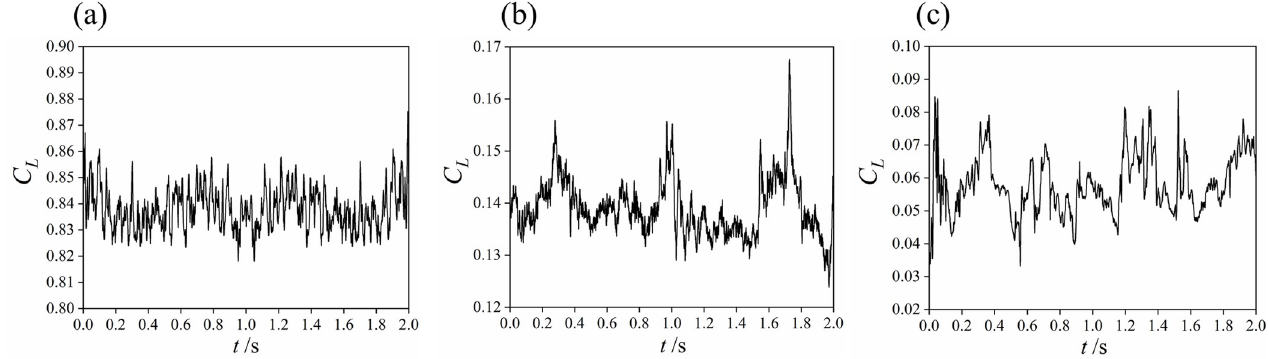
Fig 8. Time domain curves of the lift coefficient in 2 s. (a) 10% opening. (b) 50% opening. (c) 100% opening.